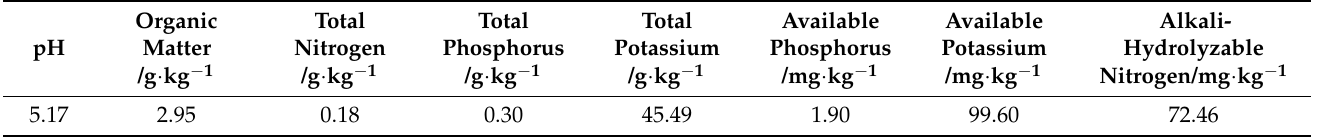
Table 1. Background value of soil chemical